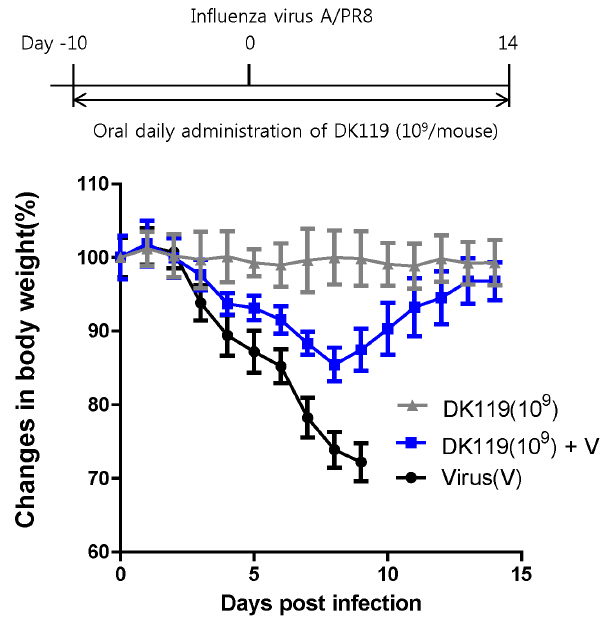
Figure 5. Oral administration of DK119 (10 9 CFU) has protec- tive effects against influenza virus infection. Mice (n=5) were administered DK119 (10 9 CFU/mouse daily) orally for 10 days before infection and for 14 days after infection with A/PR8 H1N1 virus (2.5 LD 50 ), and their body weight changes were recorded. Virus(V): A/PR8 virus infection, DK119(10 9 ) + V: Oral administration with DK119 and then virus infection. Bars indicate standard errors. DK119(10 9 ): mice treated orally with DK119 alone (10 9 CFU/mouse daily for 14 days).